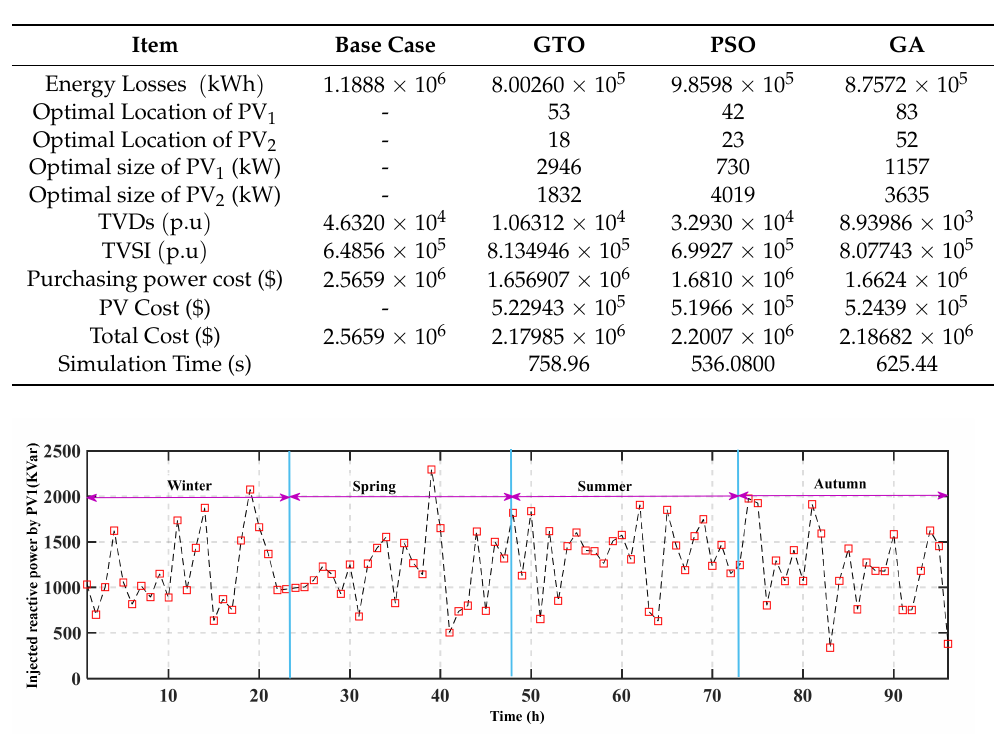
Figure 8. The reactive power injection from the first PV